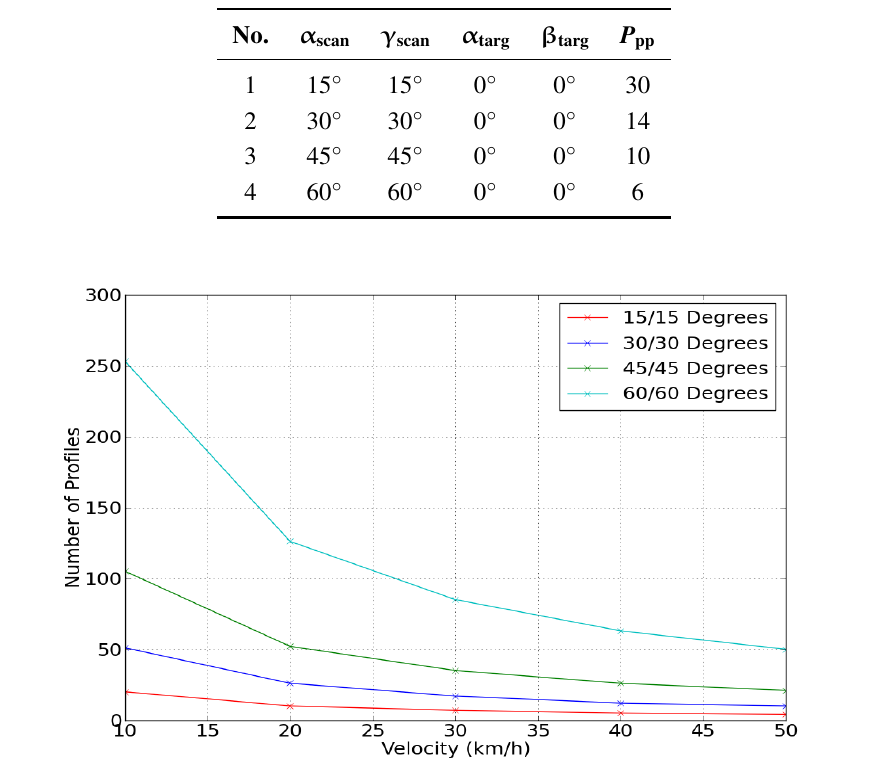
Table 7. The number of points per profile on a narrow vertical target of dimensions 0.1 m × 2 m for different dual axis scanner rotations at 5 m range and a vehicle velocity of 50 km/h.